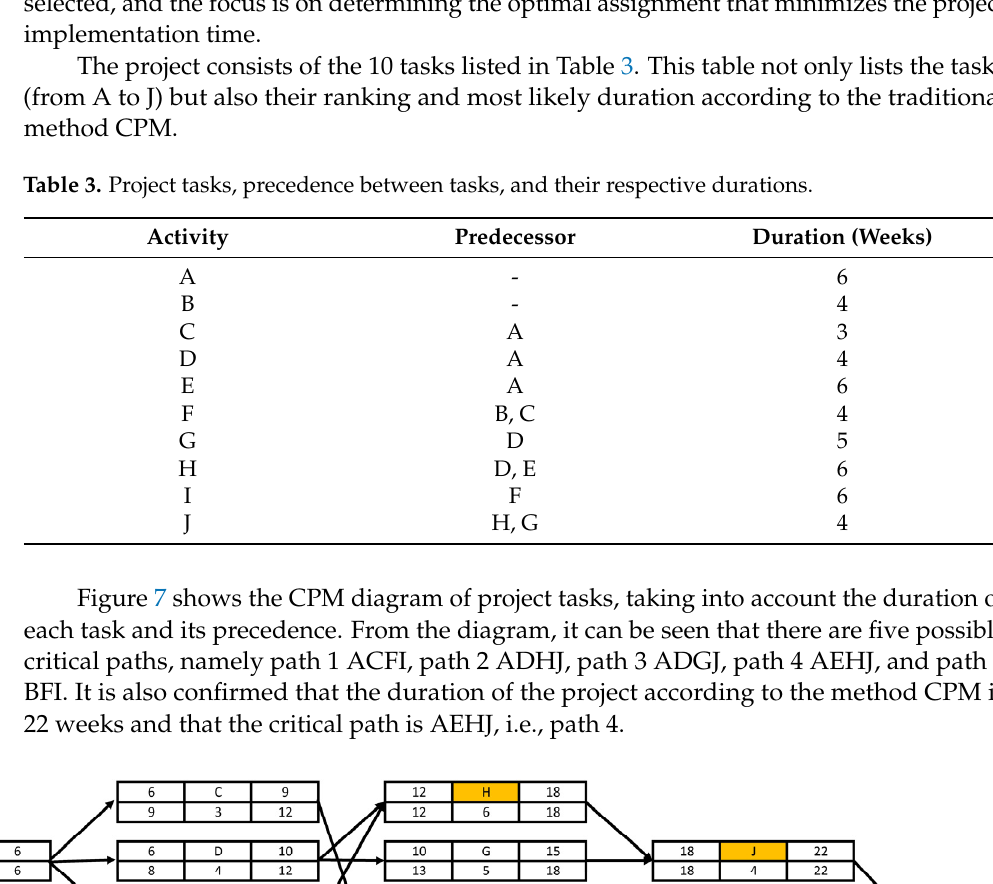
Table 4. Identification of project schedules.